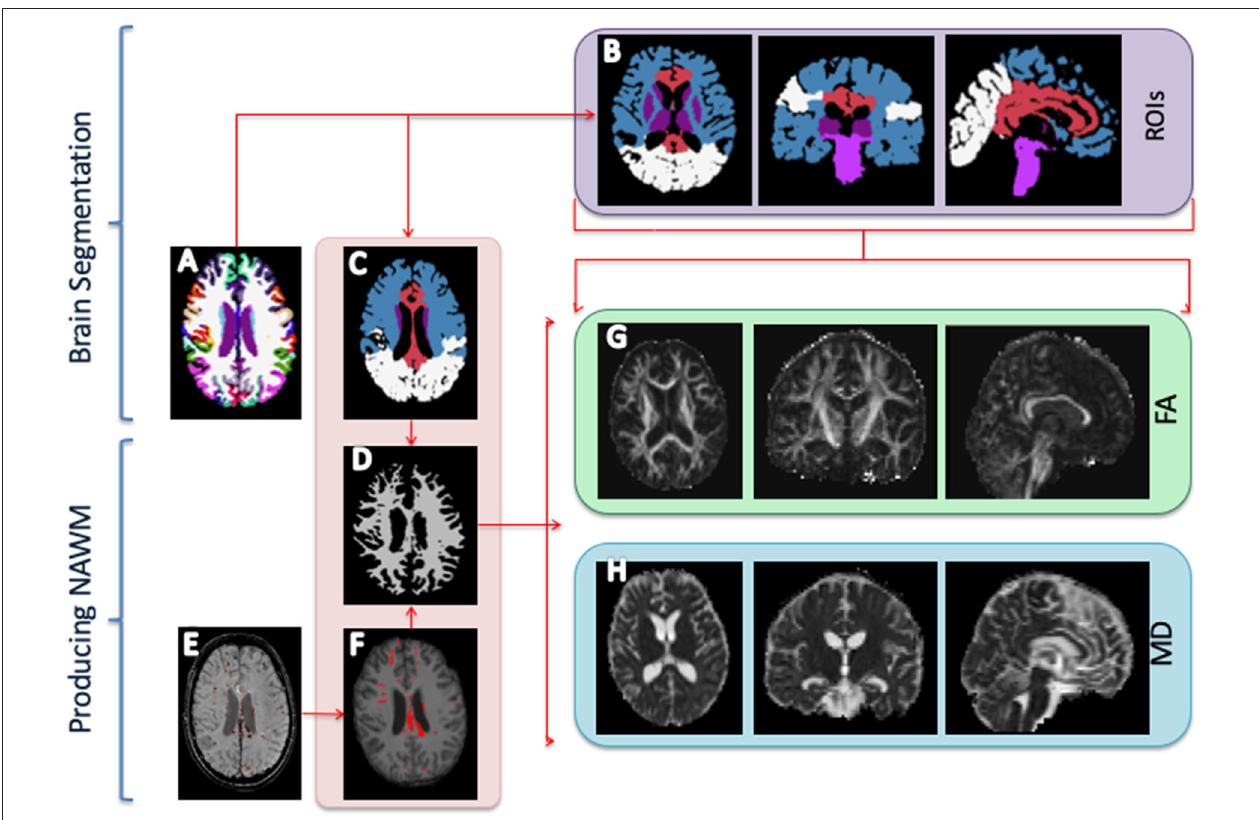
FIGURE 1 | Image processing. (A) Freesurfer segmentation. (B) Regions of interest (ROIs) segmentation: Fronto-temporal region (blue); parieto-occipital region (white); corpus callosum and parasagittal white matter (red); brainstem (pons, midbrain, and medulla) (dark purple); basal ganglia (caudate, putamen, and pallidum); and thalamus (bright purple). (C) The ROIs are used to extract regional diffusion tensor imaging indices, i.e., fractional anisotropy (FA) and mean diffusion (MD). (D) Normal-appearing white matter. (E) Manual outline of mass lesions and traumatic micro bleeds. (F) Mask of outlined lesions. (G) FA map. (H) MD